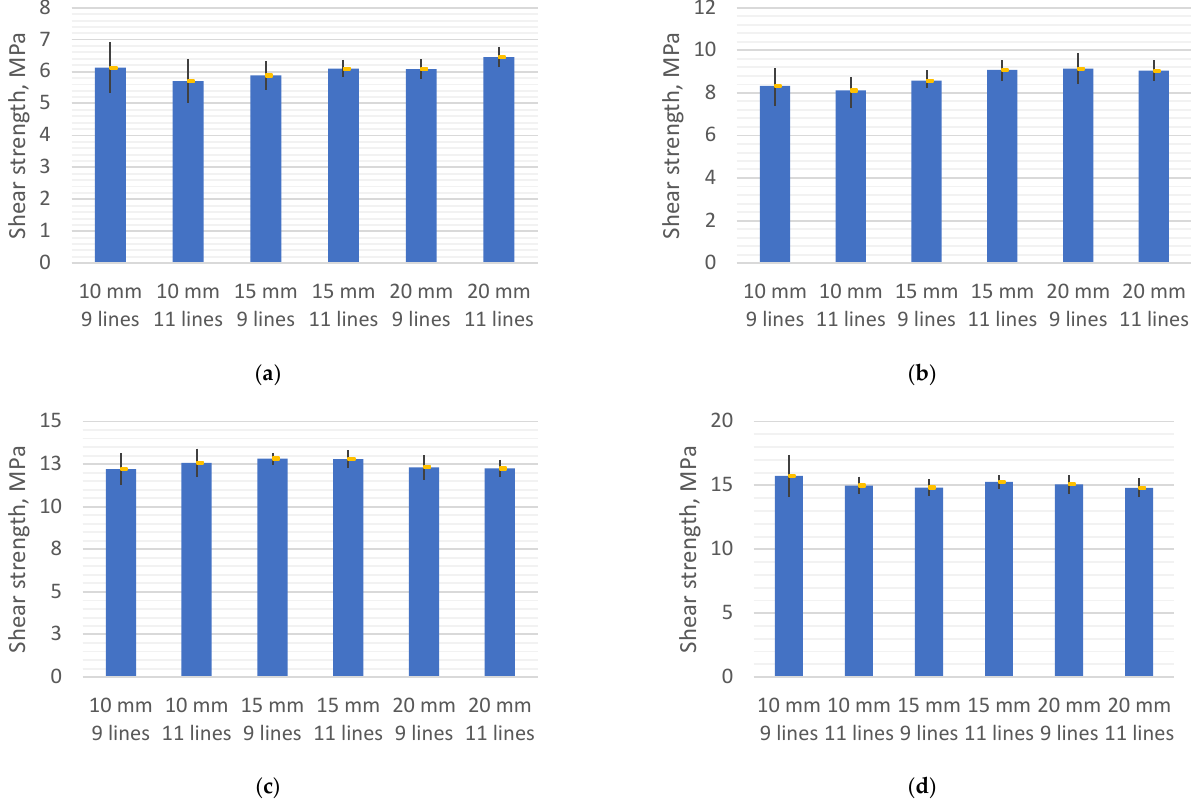
Figure 5. Diagrams of the shear strength for the specimen with different line numbers and overlap lengths: ( a ) 1.2 – 0.4; ( b ) 1 – 0.4; ( c ) 1.2 – 0.3; ( d ) 1 – 0.3 .